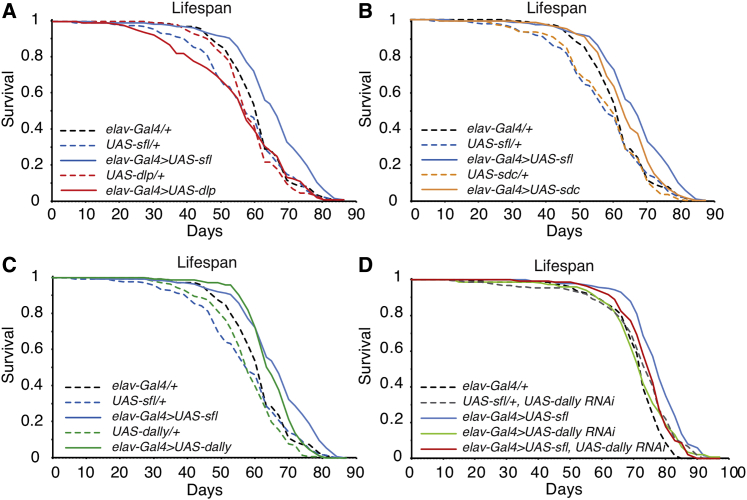
The Heparan Sulfate Proteoglycan Dally Mediates Sfl-Induced Lifespan Extension(A and B) Overexpression of the heparan sulfate proteoglycans (A) Dally-like protein (Dlp) and (B) Syndecan (Sdc) did not extend the lifespan compared with the elav-Gal4/+ driver control.(C) Overexpression of Dally extended the lifespan (Dally overexpressor versus Gal4 control, p < 0.05; Dally overexpressor versus UAS control, p < 0.01; log rank test, n = ~150) to a similar extent as overexpression of Sfl.(D) Lifespan extension mediated by Sfl overexpression was partially rescued by Dally RNAi (elav-Gal4>UAS-sfl versus elav-Gal4>UAS-sfl, dally RNAi: p < 0.001; elav-Gal4/+ versus elav-Gal4>UAS-sfl, dally RNAi: p < 0.001, log rank test; interaction between Sfl overexpression and Dally RNAi: p < 0.0001, Cox proportional hazard analysis; n = ~150).The lifespans shown in (A)–(C) were determined in parallel, and the same elav-Gal4/+, UAS-sfl/+ and elav-Gal4>UAS-sfl control lifespans are shown in (A)–(C) to allow direct comparison.